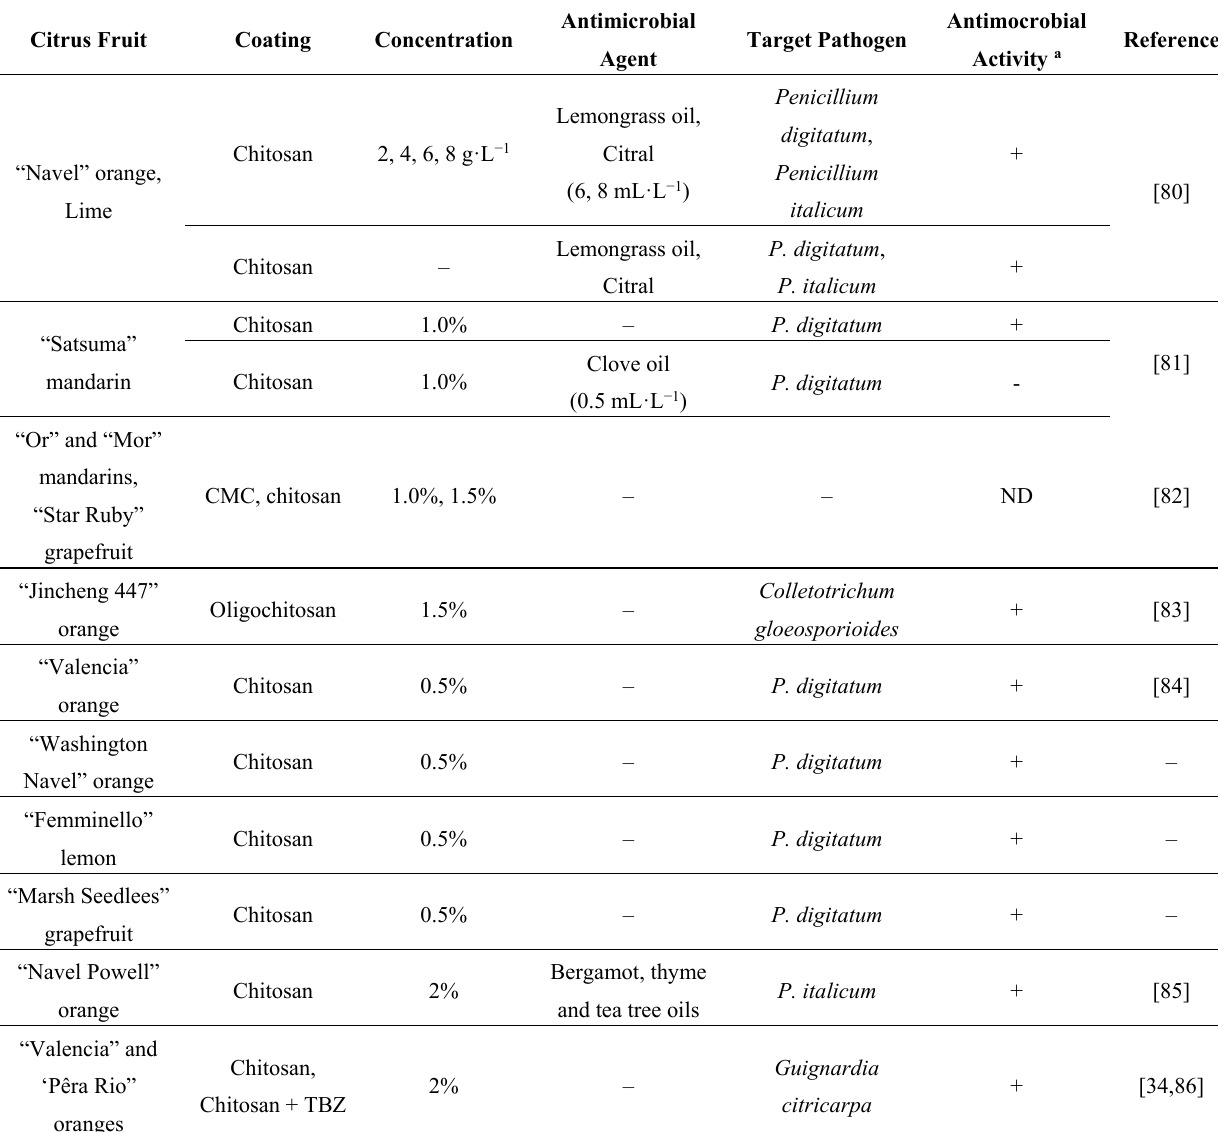
Table 1. Antifungal chitosan-based edible composite coatings applied to fresh citrus